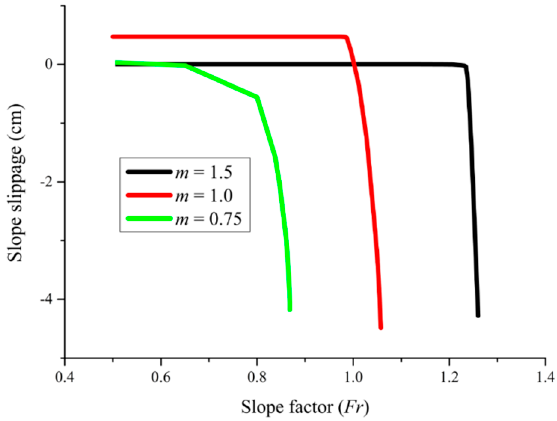
Figure 5. Trend graph of slope safety factor Fr with gradient m .